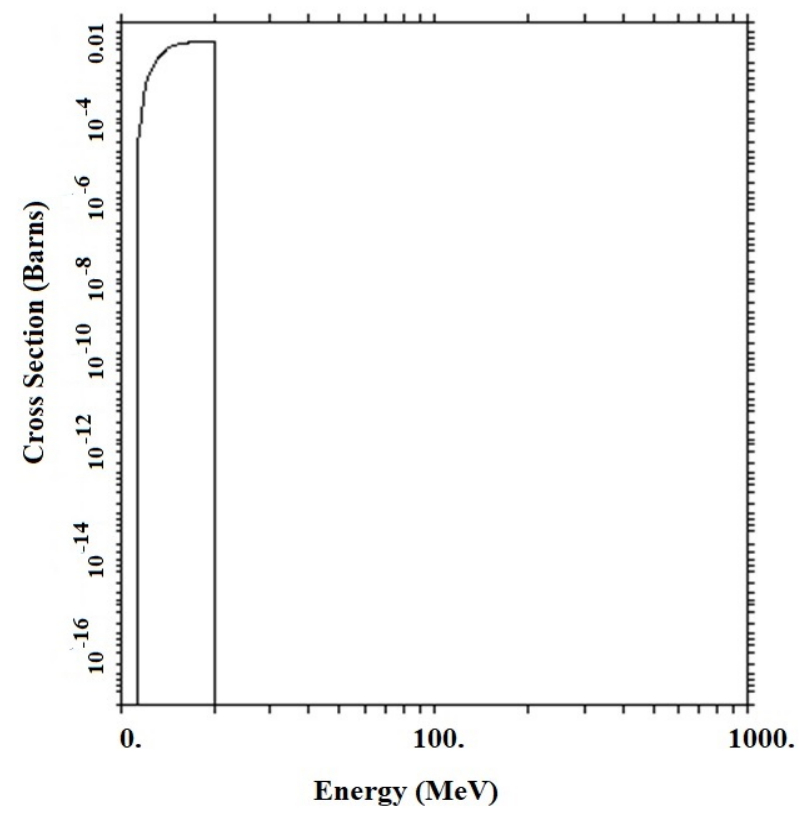
Figure 6. A X (n, 2n) A − 1 X cross-section in GS1 and GS2.